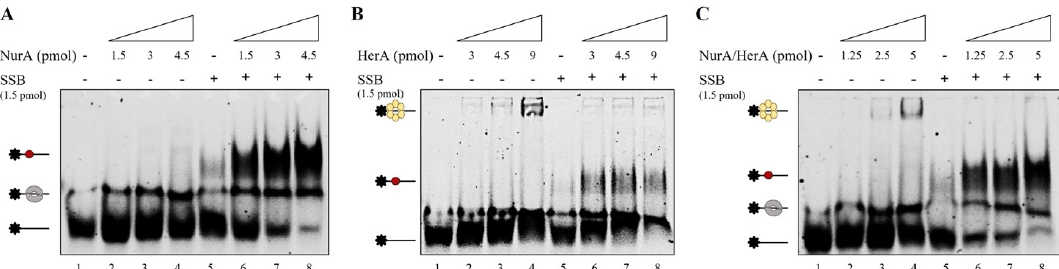
Figure 4. NurA, HerA and SSB reciprocal effect on their binding onto DNA. NurA (grey donut); HerA (yellow hexamer); SSB (red dot). ( A ) Increasing amounts of NurA were analyzed for their DNA binding affinity for a 17 merTAMRA oligonucleotide (lanes 2–4). A fixed amount of SSB was incubated with the oligonucleotide in absence (lane 5) and in presence of the aforementioned quantity of NurA (lanes 6–8). ( B ) The same experiment was performed to analyze HerA and SSB reciprocal effect on the binding onto the 17 merTAMRA oligonucleotide. Three different amounts of HerA were tested for their binding onto DNA (lane 2–4); afterward, a single amount of SSB was analyzed (lane 5), and the latter was mixed with the aforementioned quantity of HerA (lanes 6–8). ( C ) NurA/HerA complex and SSB joint effect on their binding onto DNA. Increasing amounts of NurA/HerA complex were analyzed on their binding to 17 merTAMRA oligonucleotide in the absence (lanes 2–4) and presence (lanes 6–8) of a fixed quantity of SSB (1.5 pmoles). Controls were run in lane 1, where the oligonucleotide was incubated with no proteins and lane 5, where 1.5 pmoles of SSB alone were analyzed for their binding onto DNA.